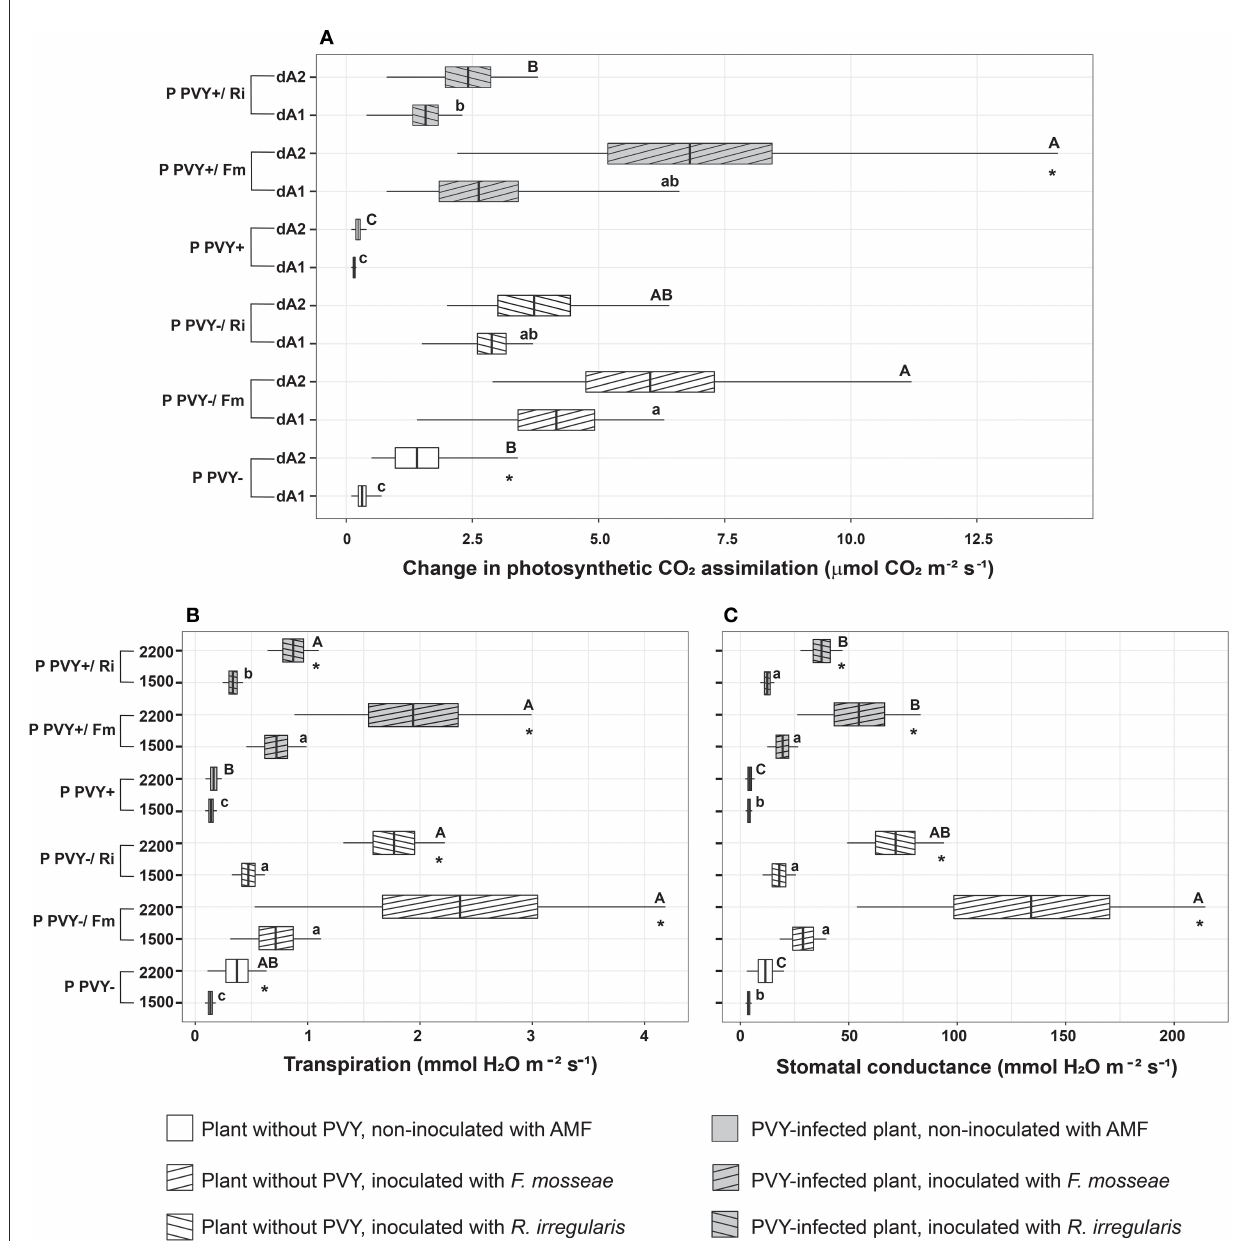
FIGURE7 The combined effect of AMF inoculation and PVY infection on photosynthetic capacity in healthy and virus-infected potatoes. Measured parameters included CO 2 assimilation rate (A) , transpiration (B) , and stomatal conductance (C) . Values dA1 (A 800 -A 500 ) and dA2 (A 1,200 -A 500 ) show changes in the assimilation rate between two different light intensities. The statistically significant differences are marked with letters. The same letters indicate no significant differences ( p > 0.05). The asterisk means significant difference between each two parameters measured for the experimental variant (for A : dA1 and dA2; for B, C : 1500 and